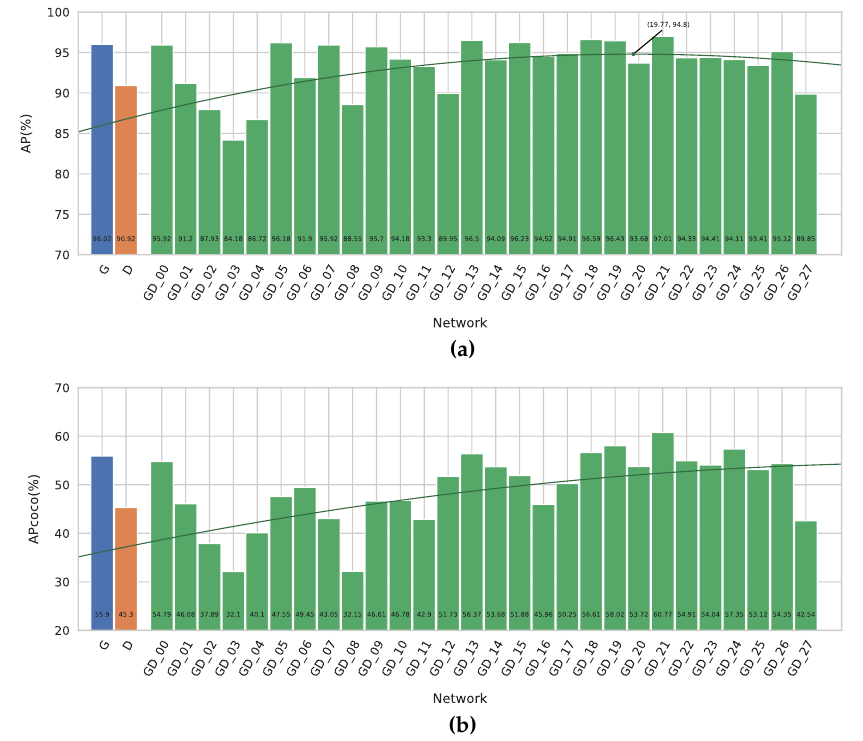
Figure 8. The results of our different networks on the GD Screws Dataset. ( a ) The regular AP metric of our different networks. ( b ) The AP COCO metric of our different